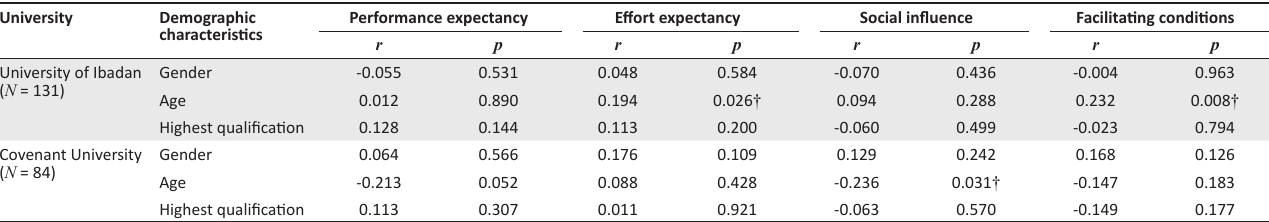
TABLE 5: Correlation analysis between demographic characteristics and underlying factors of information and communication technology use in teaching. University